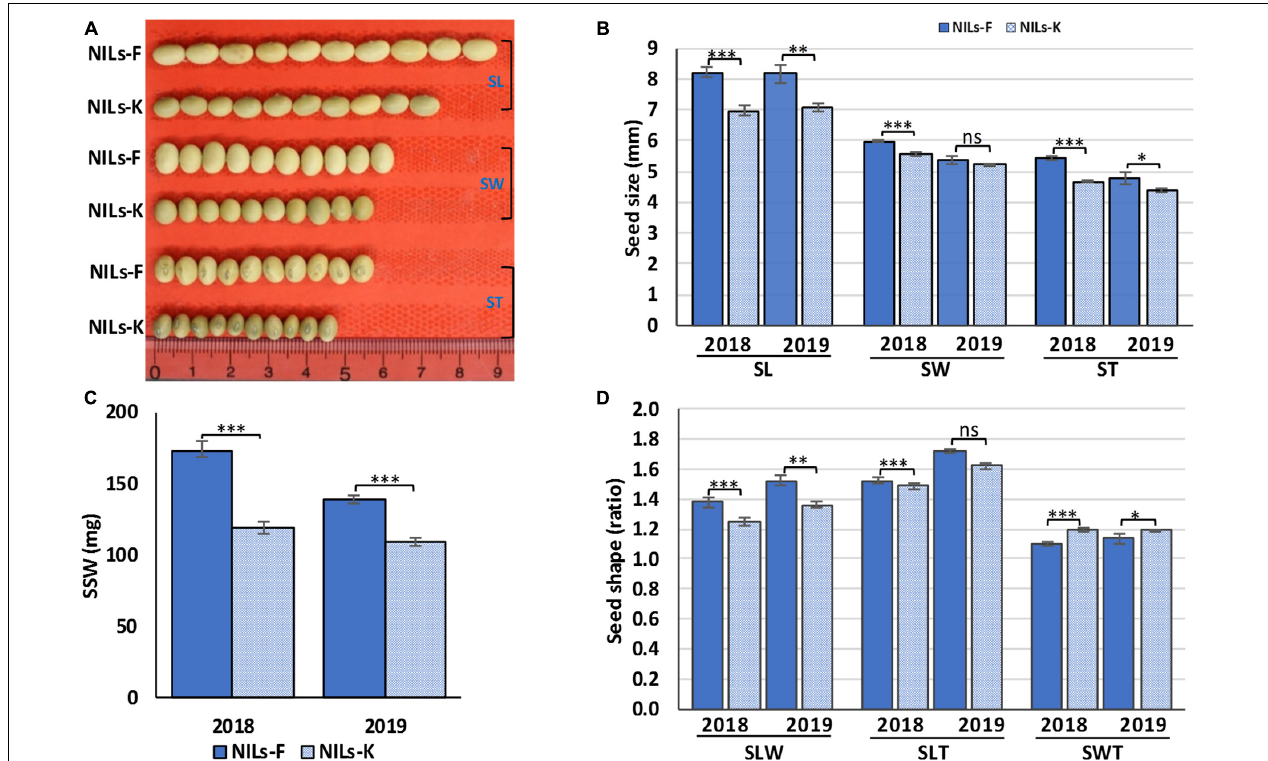
FIGURE 4 | Seed size and shape phenotypes of near isogenic lines, NILs-F and NILs-K in 2018 and 2019, (A) phenotypic appearance, (B) SL, seed length; SW, seed width; ST, seed thickness, (C) single seed weight (SSW), and (D) seed shape traits (SLW, ratios of seed length-to-width; SLT, seed length-to-thickness; and SWT, seed width-to-thickness). Error bars represent means ± SD of three replicates. Asterisks indicate significant differences between NILs-F and NILs-K at 5% ( ∗ ), 1% ( ∗∗ ), and 0.1% ( ∗∗∗ ); ns indicates no significant difference at the 5% level in Student’s t -test.